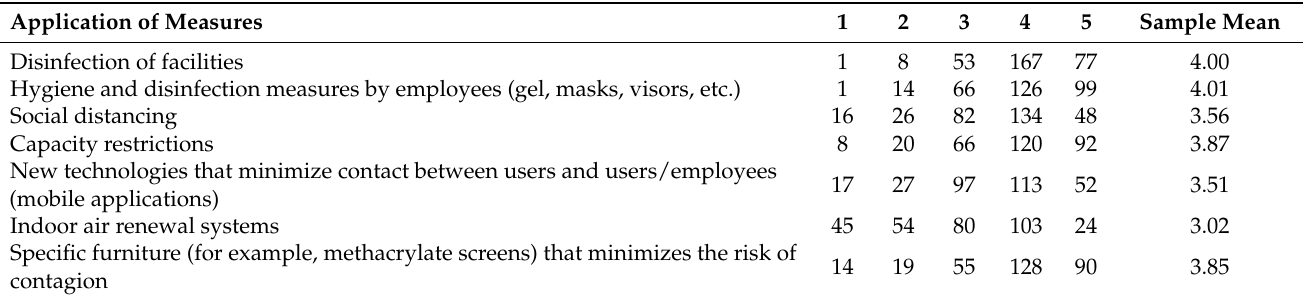
Table 2. Perception of the level of implementation of safety and security measures in HORECA establishments for the Region of Murcia (in number of users surveyed).